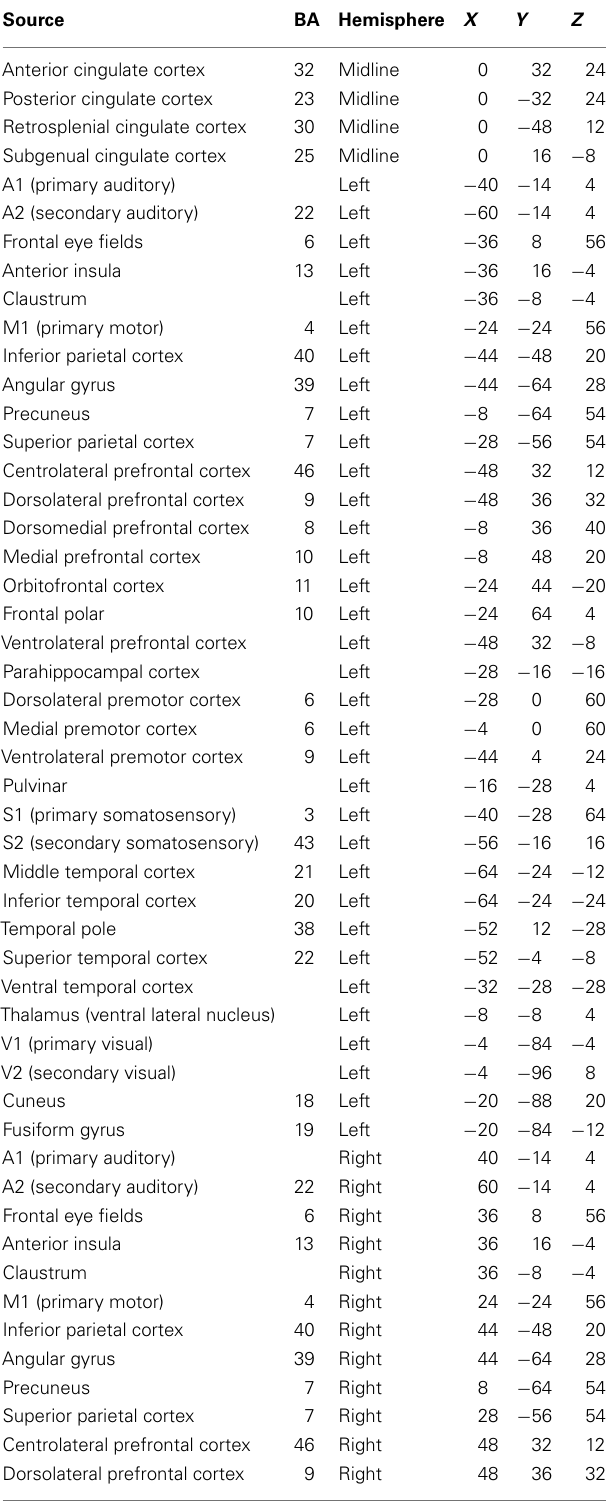
Table 2 | Each source location used in the analysis of spontaneous MEG activity, together with associated Brodmann area andTalairach coordinates.